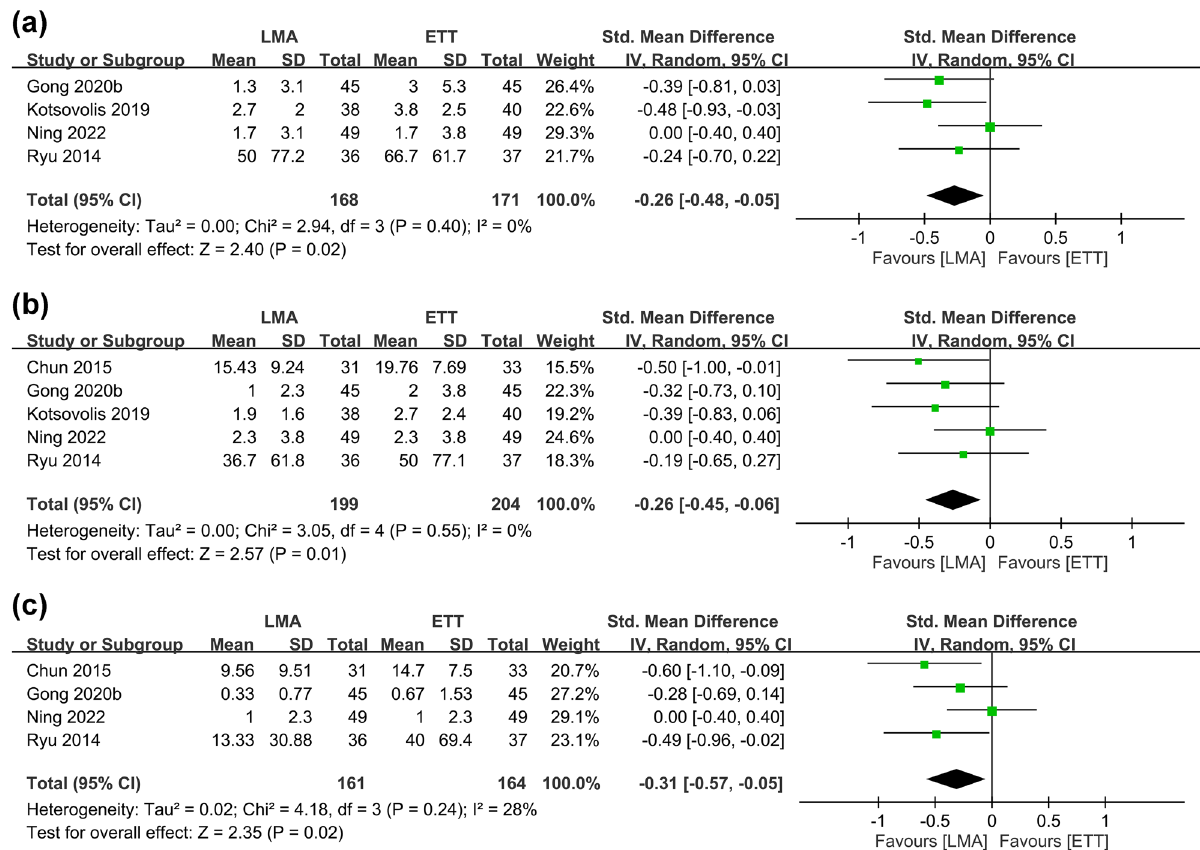
Figure 4. Forest plot comparing the severity of postoperative sore throat at ( a ) 1 h, ( b ) 24 h, and ( c ) 48 h between laryngeal mask airway (LMA) and endotracheal tube (ETT) groups. CI confidence interval, IV inverse variance, Std